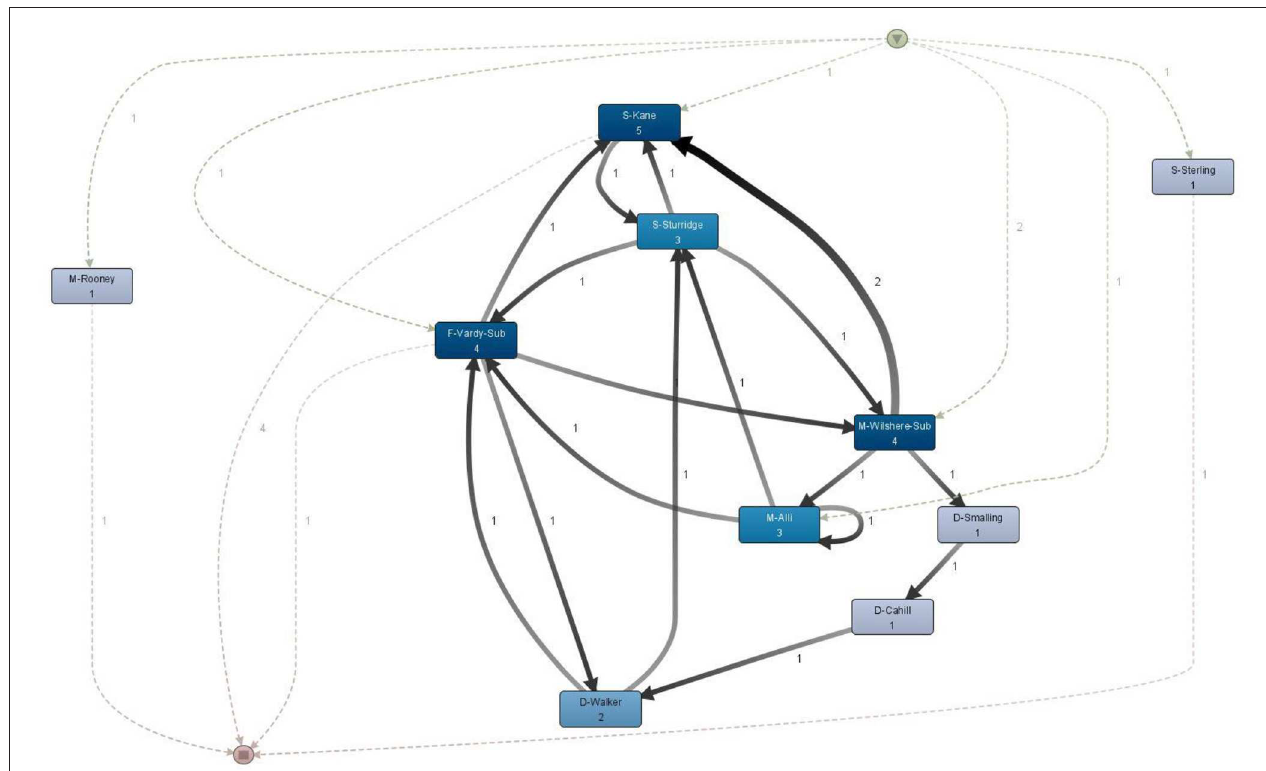
FIGURE 4 | England’s offensive sequences ending in a “goal” or “attempt